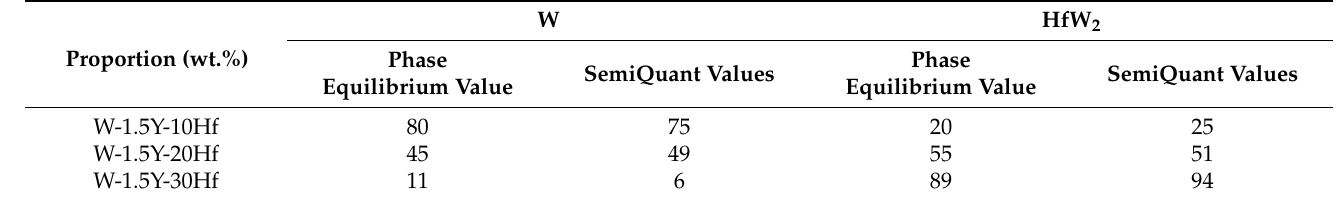
Table 1. Phase equilibrium values and SemiQuant values of different phases in